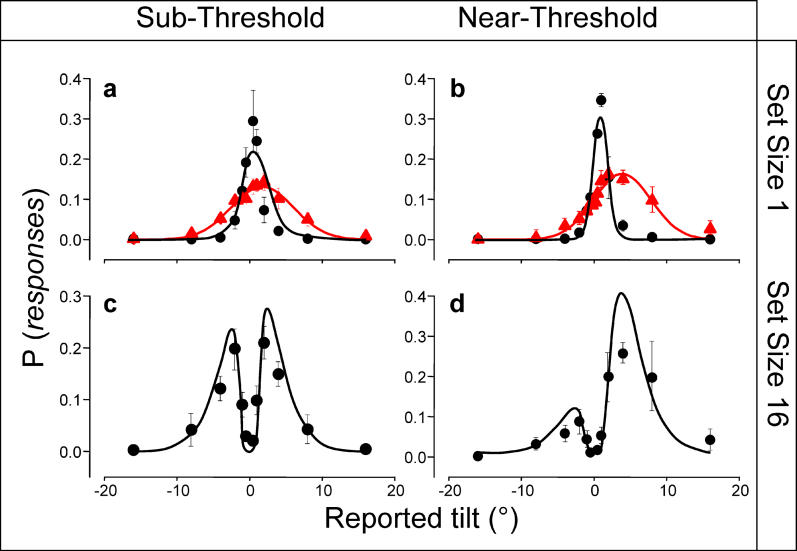
Average Response Distributions for Subthreshold and Near-Threshold StimuliDistributions are shown at set sizes 1 and 16 (top and bottom row, respectively) for subthreshold (left column) and near-threshold (right column) stimuli. Axes and symbols follow the same convention as inFigure 3. Data show the average of all four subjects, with error bars referring to the standard error of their individual means. At set size 1 the average response distributions are clearly Gaussian-like for both stimulus levels (no curves significantly bimodal), agreeing well with predictions. At set size 16, both distributions are clearly (and significantly) bimodal, again agreeing with predictions.